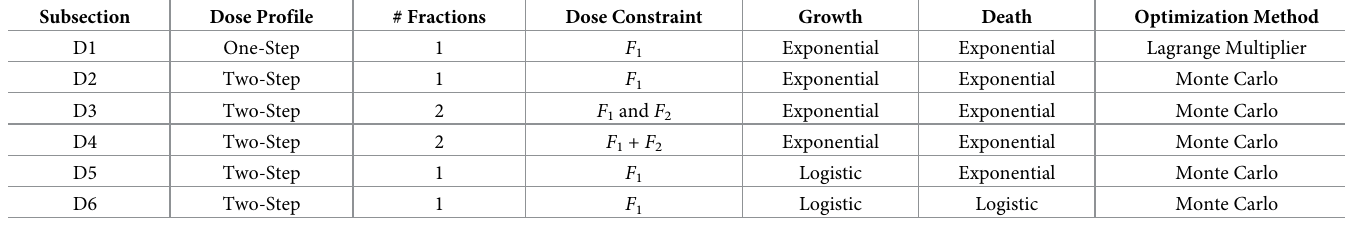
Table 11. Summary of discrete optimization